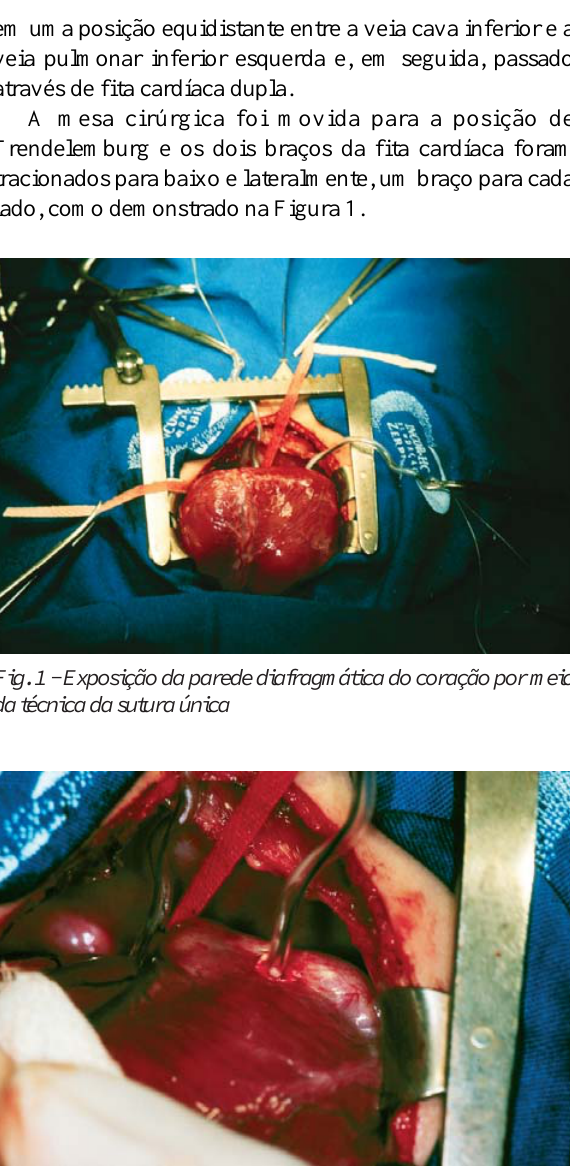
Fig. 2 - Interrupção do fluxo do trato fistuloso com o torniquete Um torniquete foi utilizado para interromper o fluxo através da fístula coronariana após a passagem de um ponto em “U”, utilizando fio de Mercilene® 2.0 com “ pledgets ” ao redor da fístula (Figura 2). Assim, o comportamento